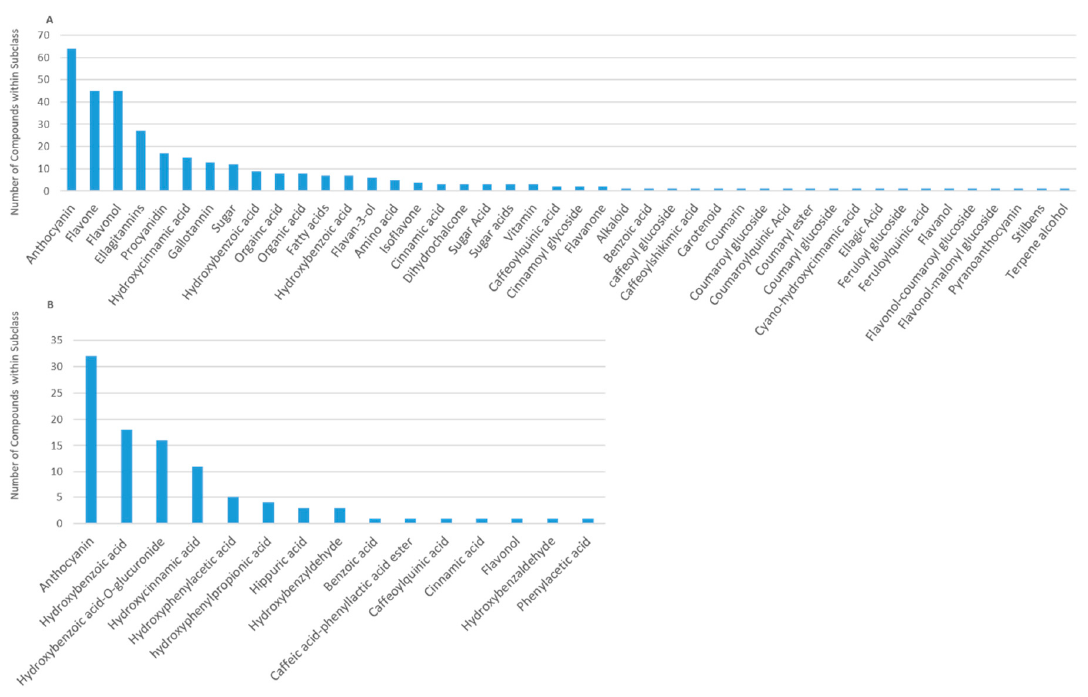
Figure 3. Diversity of plant secondary metabolite reported in berry studies ( A ) and their human metabolites ( B ).